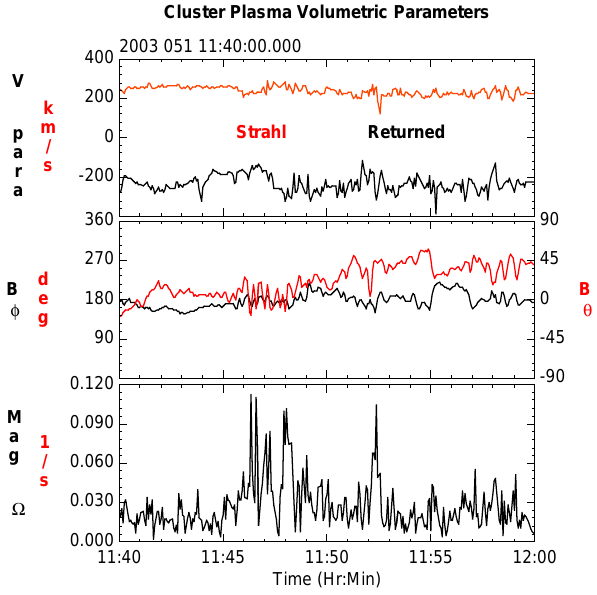
Fig. 9. High resolution plot of the parallel strahl and return veloci- ties, the φ and θ GSE components of the C1 magnetic field and the magnitude of the vorticity for time around the large magnetic field rotation.